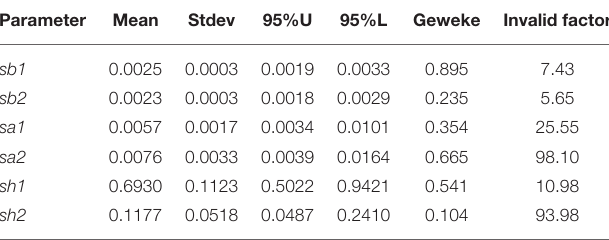
TABLE 3 | Results and diagnosis of MCMC estimation of US. Parameter